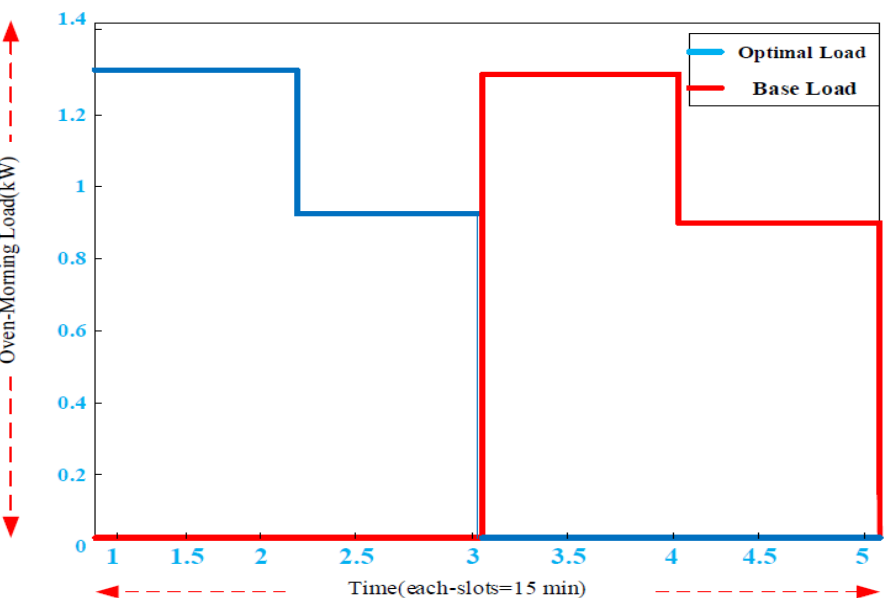
Figure 15. Oven consumption profile at night.